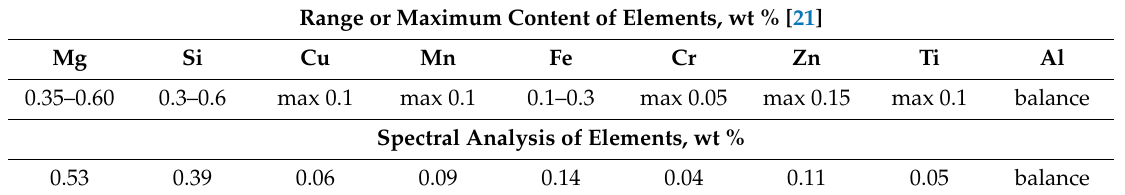
Table 1. Chemical composition of 6060 aluminum alloy. Range or Maximum Content of Elements, wt %